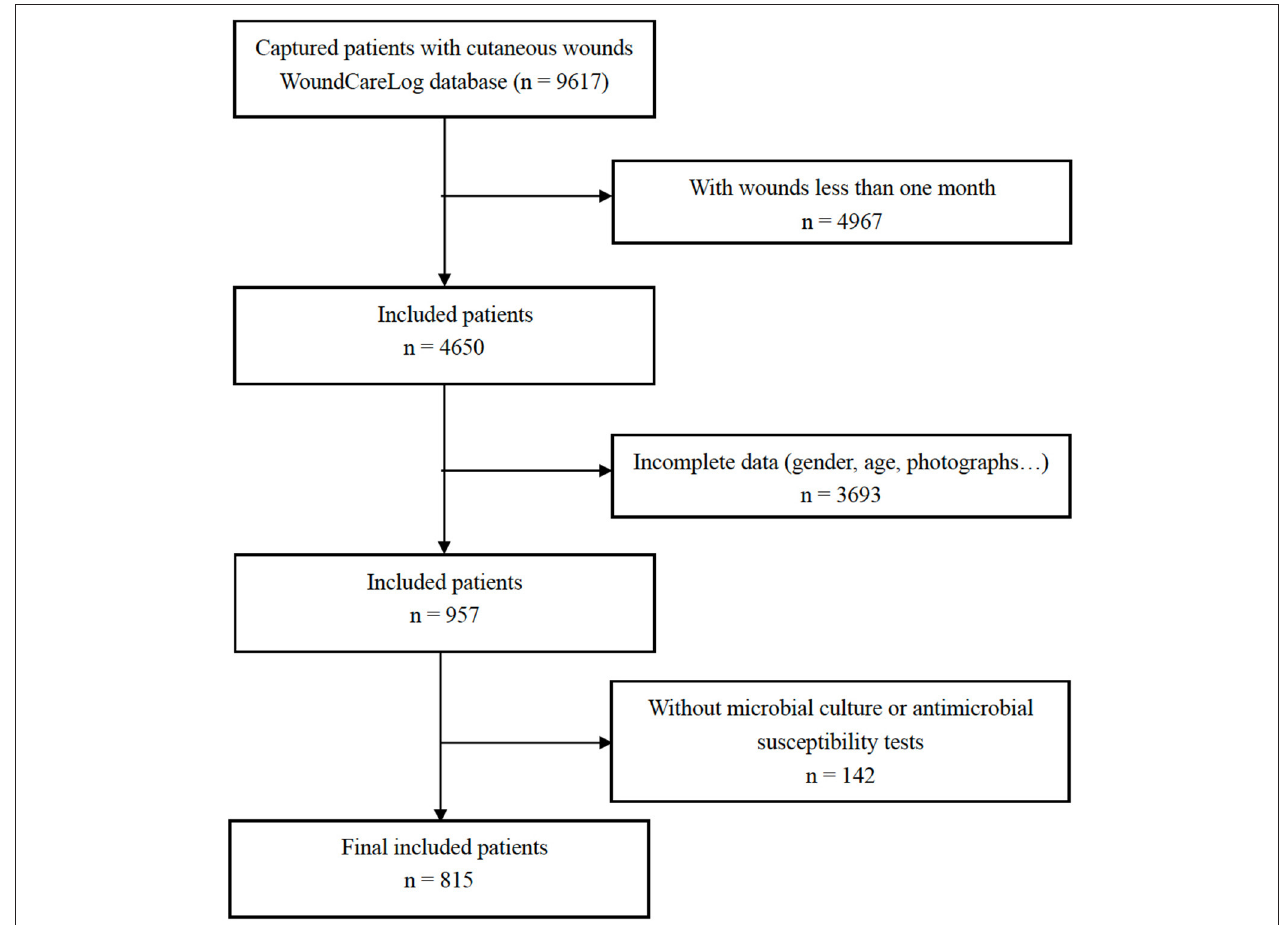
FIGURE 1 | Study selection